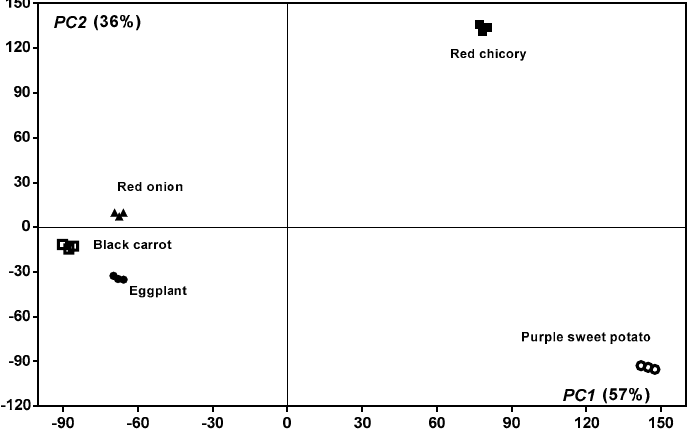
Figure 8. Principal component analysis of spectrophotometric and chromatographic data.